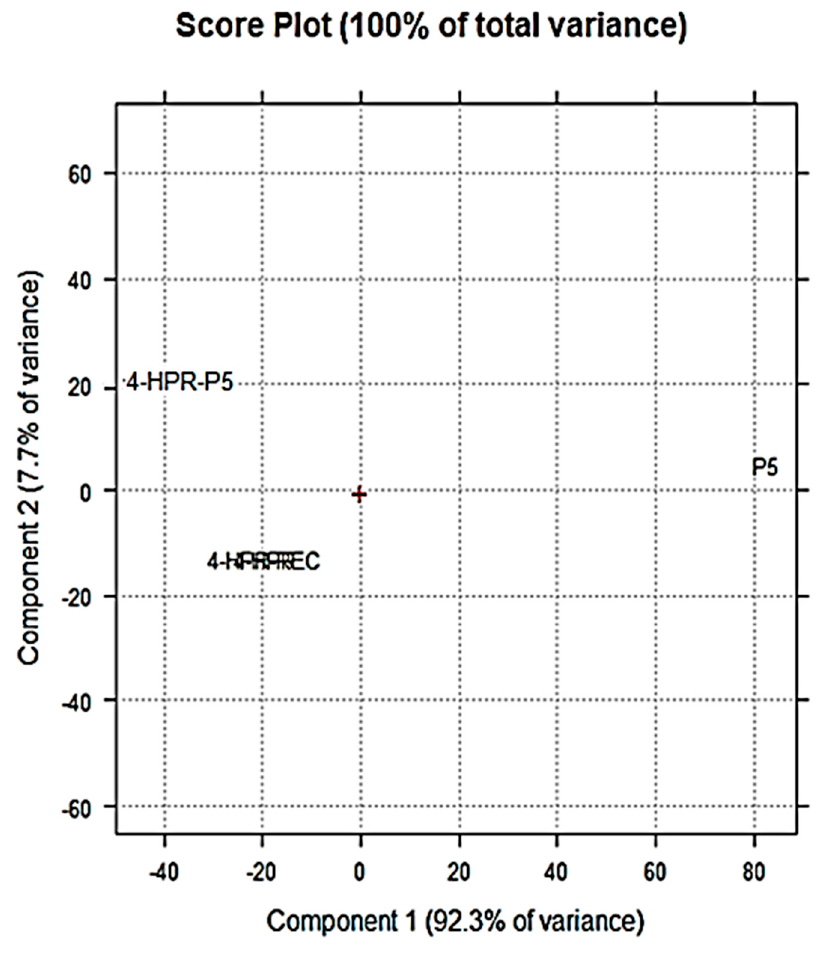
Figure 2. PCA results, represented as a score plot (PC1 vs. PC2).